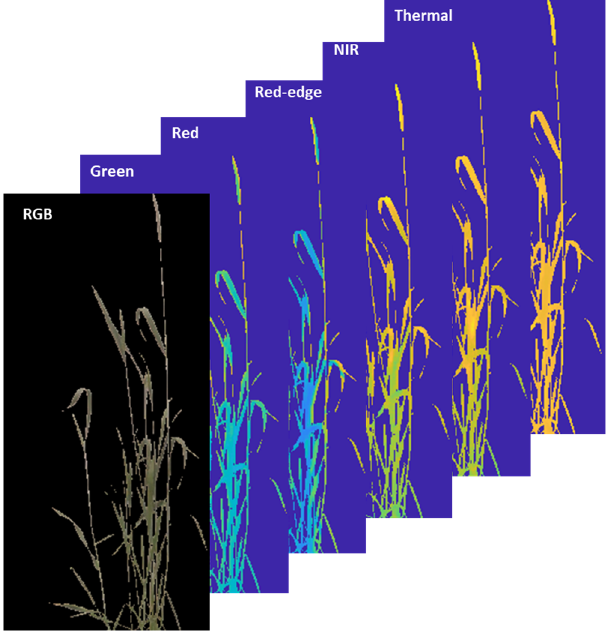
Figure 11. An eight-band stacked image representing only the canopy pixels in the following order: RGB, green, red, NIR, red-edge, and thermal. Each pixel of an image represents the same pixels for the other images, which are represented by red squares in the images.